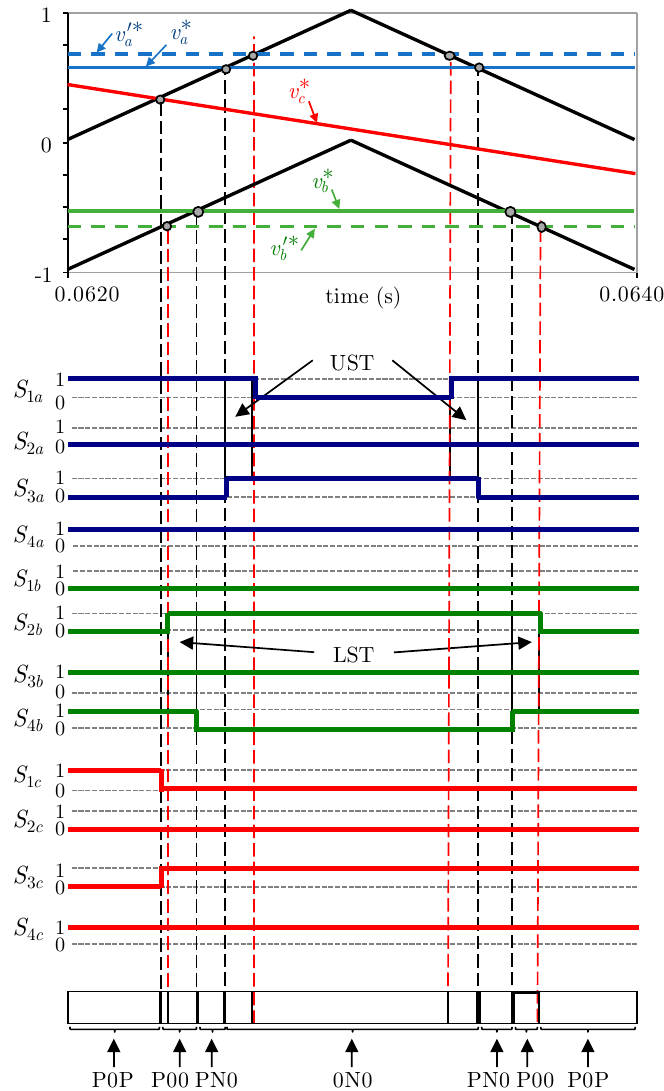
Figure 5. Reference, carrier, and gate signals of the proposed modulation scheme for the switching cycle T (0.0620 s to 0.0621 s) highlighted in Figure 4.